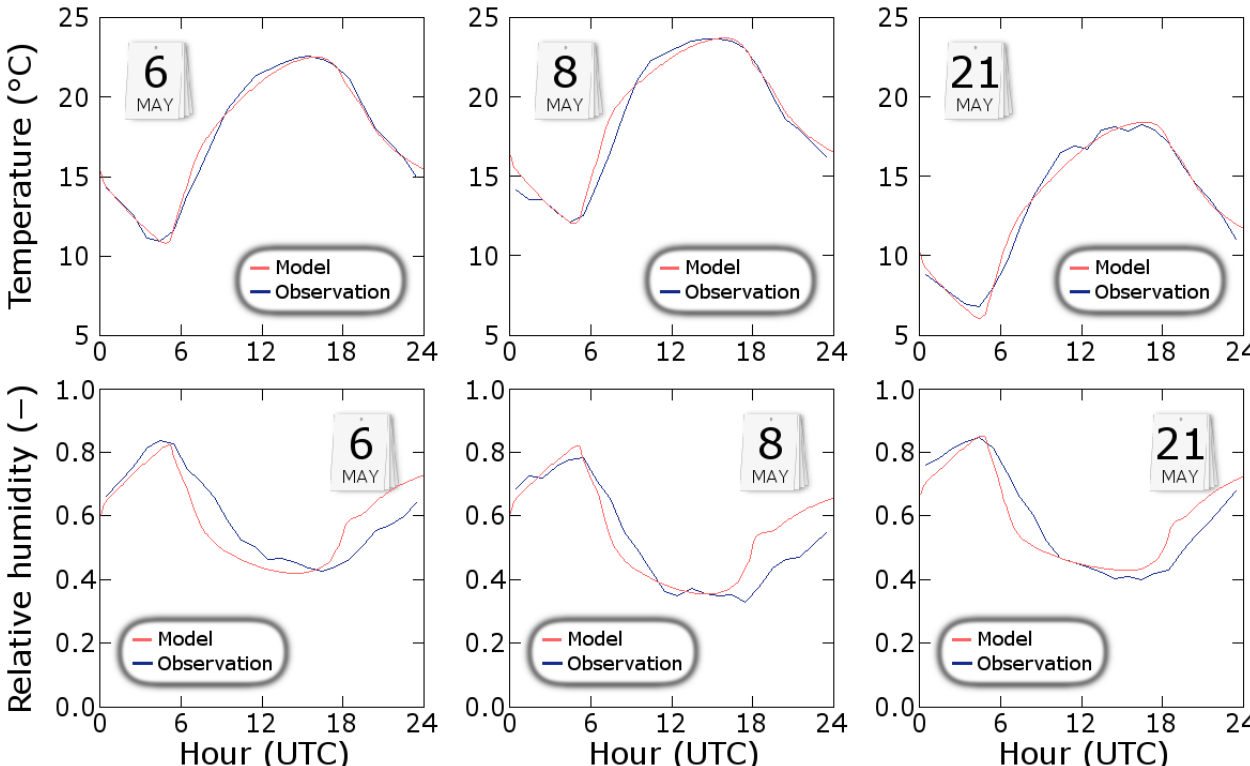
Fig. 3. Upper panels: observed and modelled surface temperature for 6 May (left), 8 May (middle) and 21 May (right). Lower panel: observed and modelled relative humidity for these days.